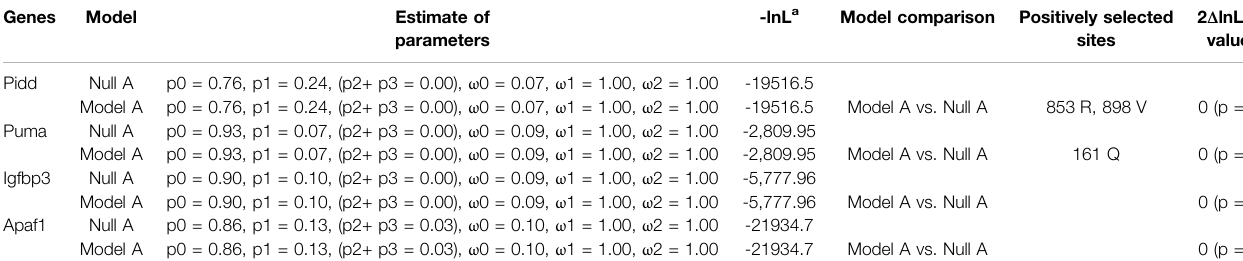
TABLE 3 | Likelihood ratio test (LRT) of branch-site models for apoptosis-related genes in plateau zokor. Genes Model